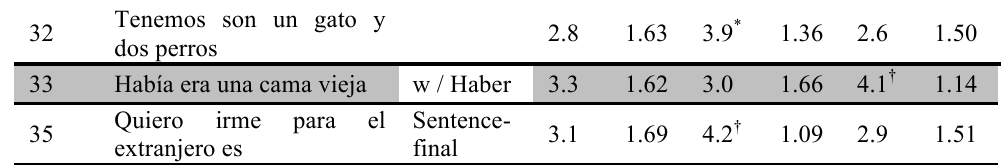
Table 4: List of all cases of FS focus evaluated in the second